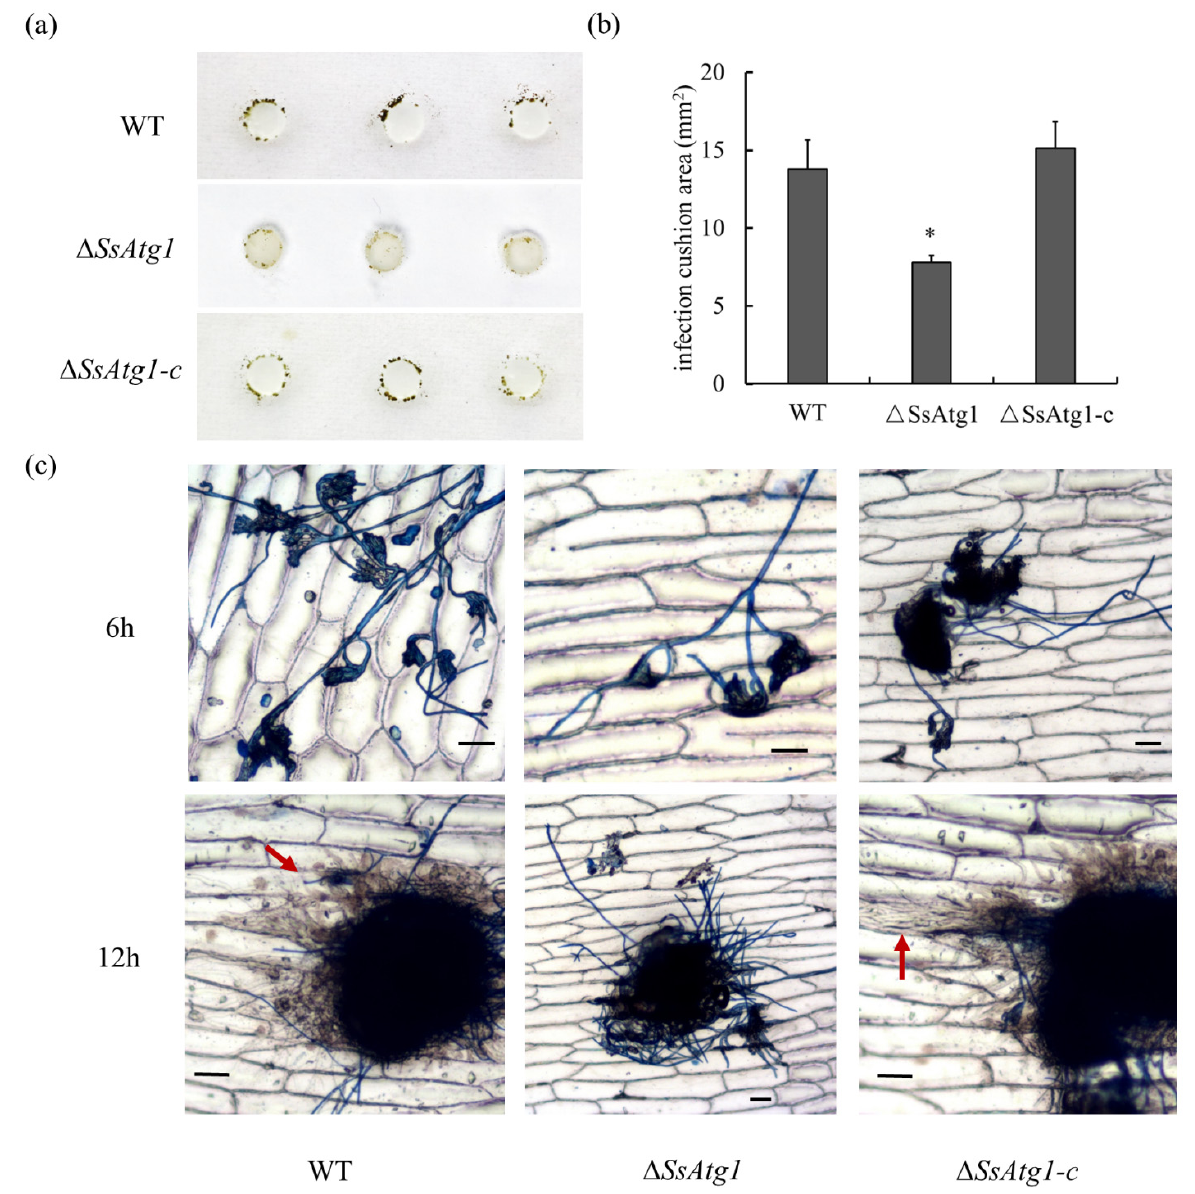
Figure 7. SsAtg1 affected compound appressoria formation and penetration. ( a , b ) Compound appressoria of strains on hydrophobic interface. Image J was used for analysis of compound appressoria as: adjusted the image to 8 bit format, then selected the part of the compound appressoria by adjust-threshold, then using the area of the agar disk as the control to calculate the area of the compound appressoria. Error bars represent the standard deviations and the asterisk indicated significant differences (p < 0.05). ( c ) Compound appressoria formation on onion epidermal cells. The red arrow shows the invasion hypha which could not be stained by lactophenol cotton blue solution. Samples were staining by lactophenol cotton blue solution after 30 s, then washed with ddH 2 O and observed under a microscope. Scale bar = 50 μ m.